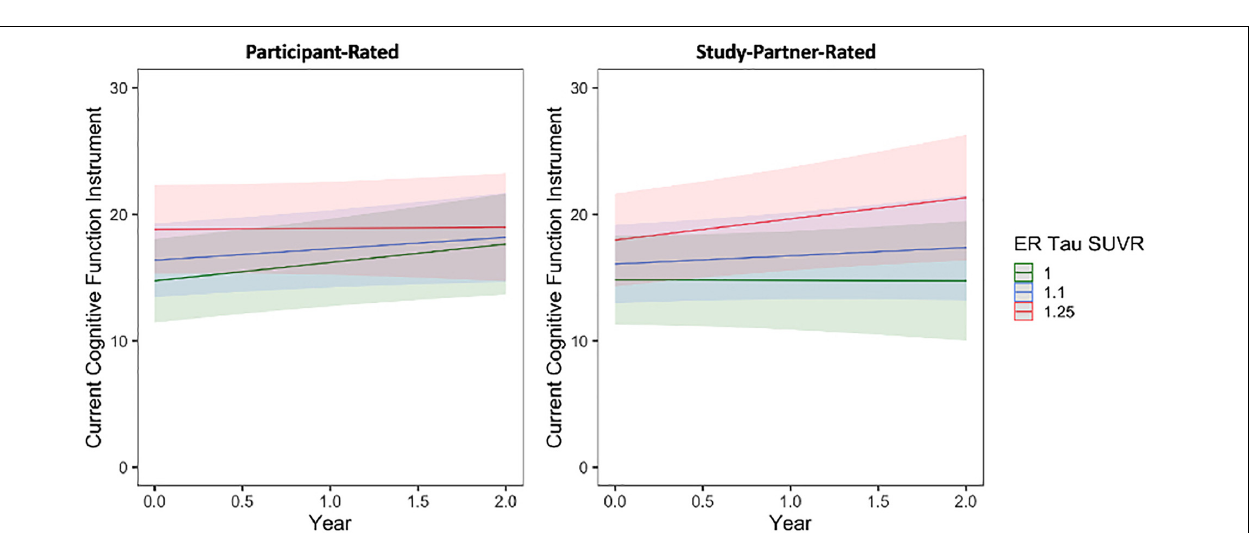
FIGURE 5 | The interaction between baseline participant cerebral entorhinal tau burden (ER SUVR) and time to predict participant-rated (left) and study partner-rated (right) cognitive concerns using the current CFI. A significant interaction was seen between tau and time when predicting study partner-rated cognitive concerns (fixed estimate = 3.50, adj. p = 0.030), in that study partner concerns increased over time in participants with higher tau burden at baseline. The interaction between tau and time predicting participant-rated cognitive concerns was not significant (fixed estimate = –1.47, adj. p =